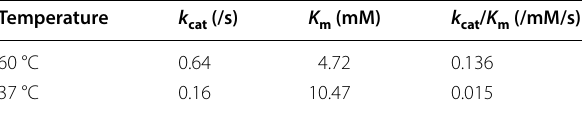
Table 3 Kinetic parameters of AfPase against DHAP in 100 mM HEPES (pH 7.0) containing 5 mM MgCl at different